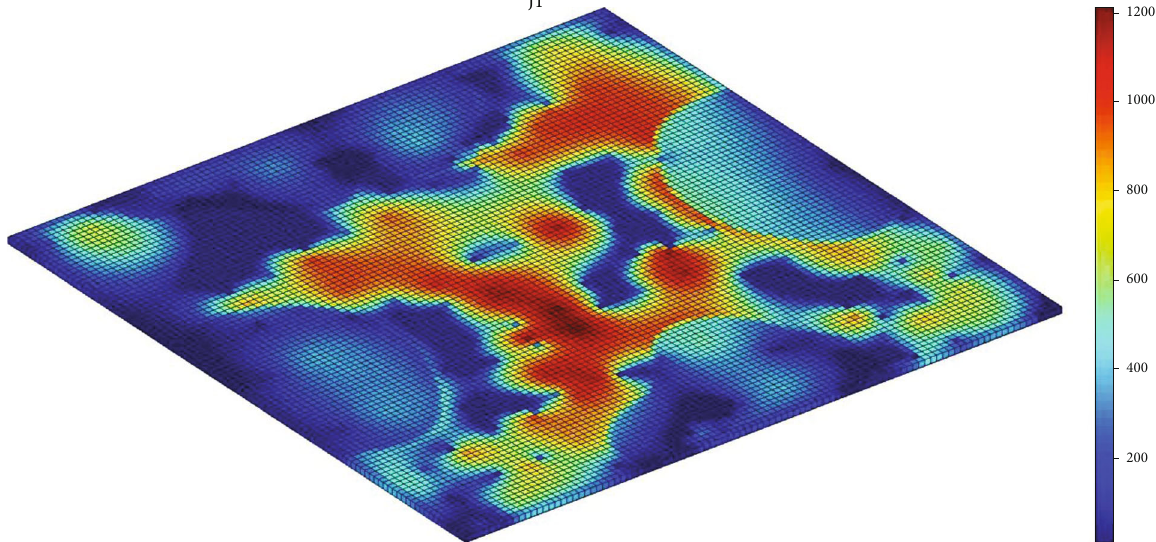
Figure 7: The productivity potential of the modi fi ed equation.